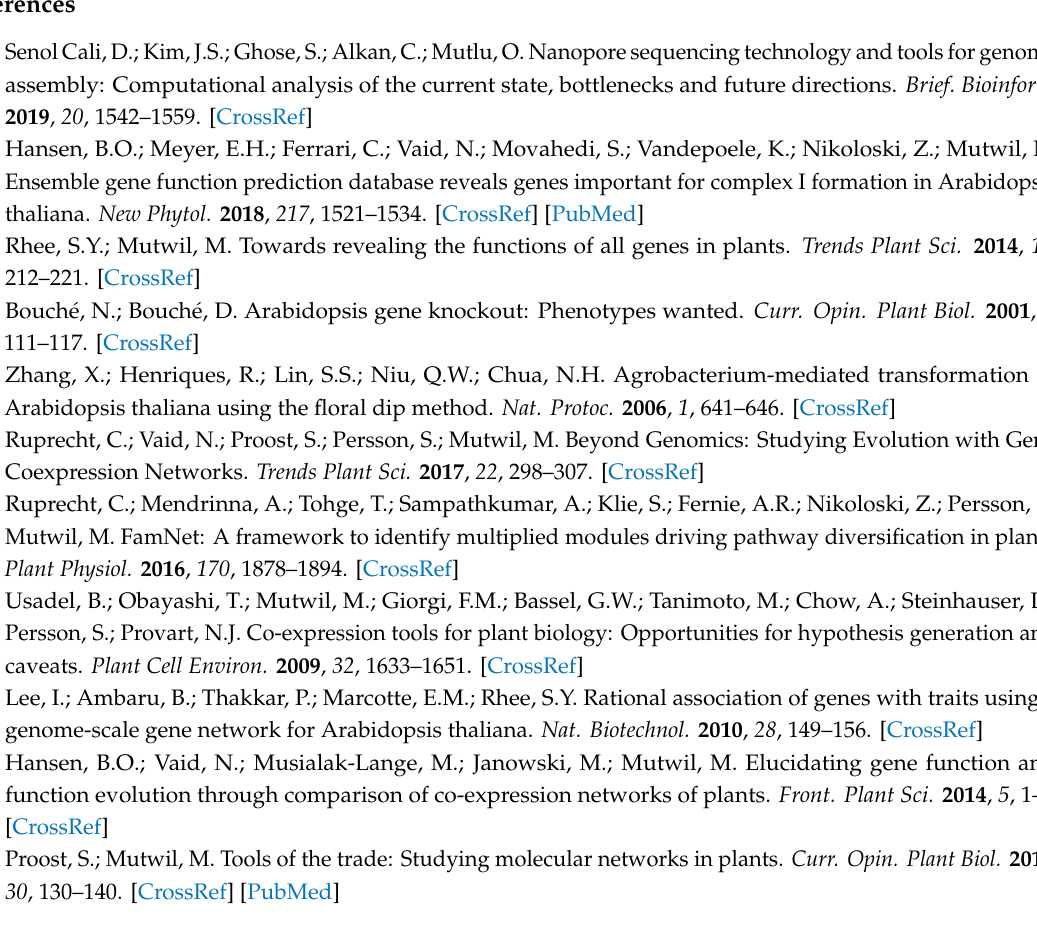
Figure S1: Complete coexpression network of A622 ( Nitab4.5_0000884g0010.1 ), Table S1: SRA run table from NCBI SRA, Table S2: Download report of N. tabacum RNA-seq experiments streamed using LSTrAP-Cloud, Table S3: Annotation of N. tabacum CDS by Mercator, Table S4: Neighbourhood of A622, Table S5: BLAST output of genes involved in nicotine biosynthesis, Table S6: Summary of RNA-seq experiments included in the calculation of relative gene expression, Document S1: User manual for